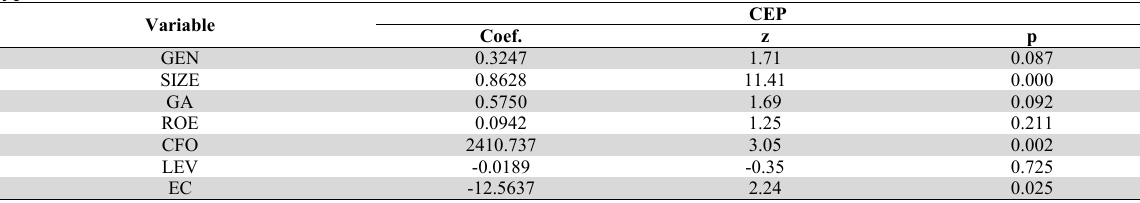
Hyphothesis 1 test